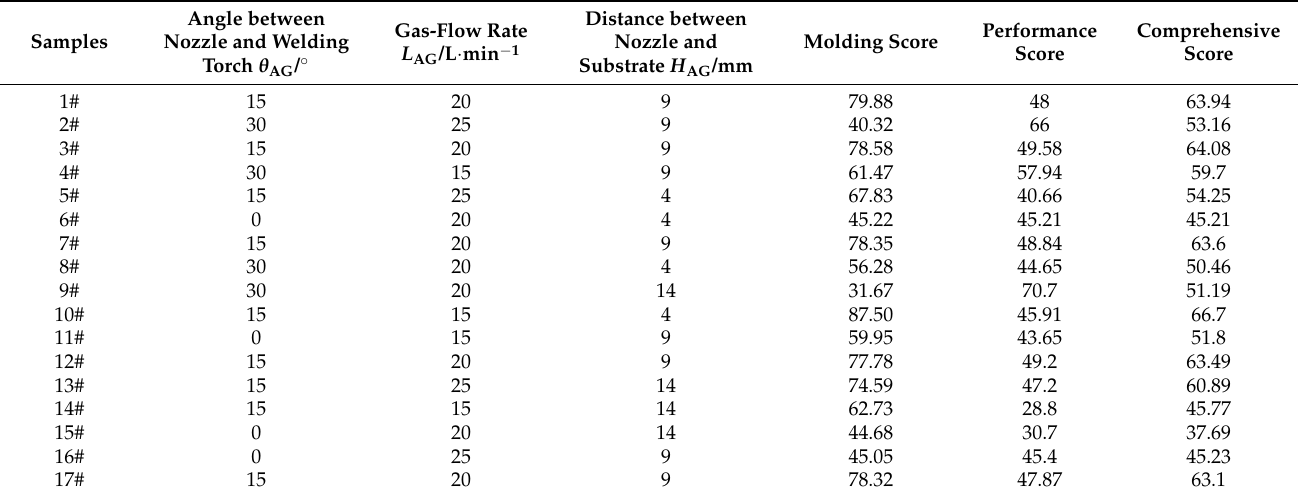
Table 2. Experimental groups of the BBD response surface methodology (BBD represents Box–Behnken Design). Angle between Samples Nozzle and